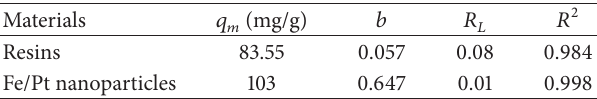
Table 1: Langmuir isotherms constants of nitrate ions adsorption by nanoprticles and